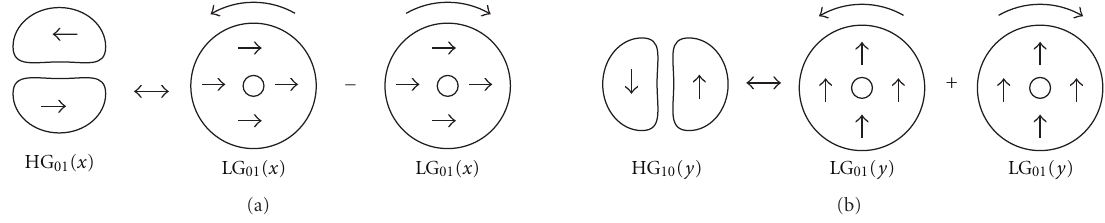
Figure 22: Conversion between linearly polarized HG and LG